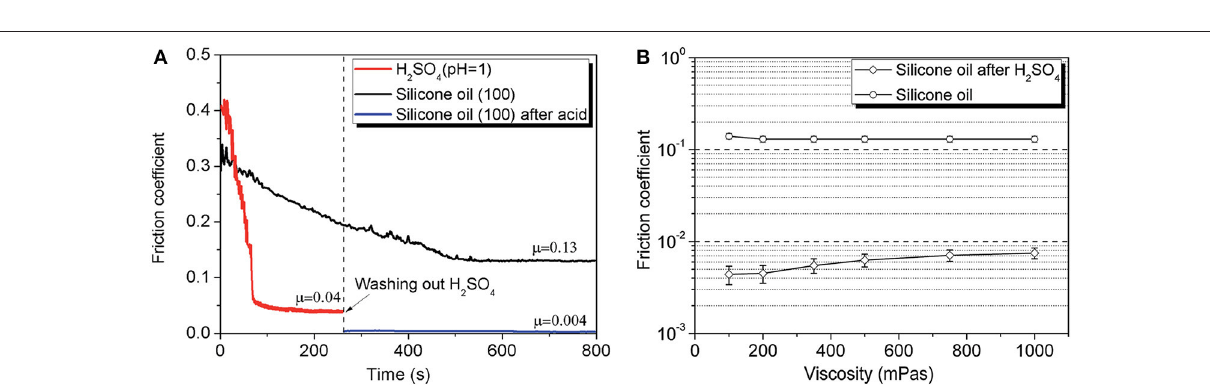
FIGURE 11 | (a) Evolution of the COF with time. The inset shows the main chemical structure of castor oil. (b) Lubrication diagrammatic sketch of the tribopair under castor-oil lubrication. Zeng et al. (2016) Copyright 2016, Nature.